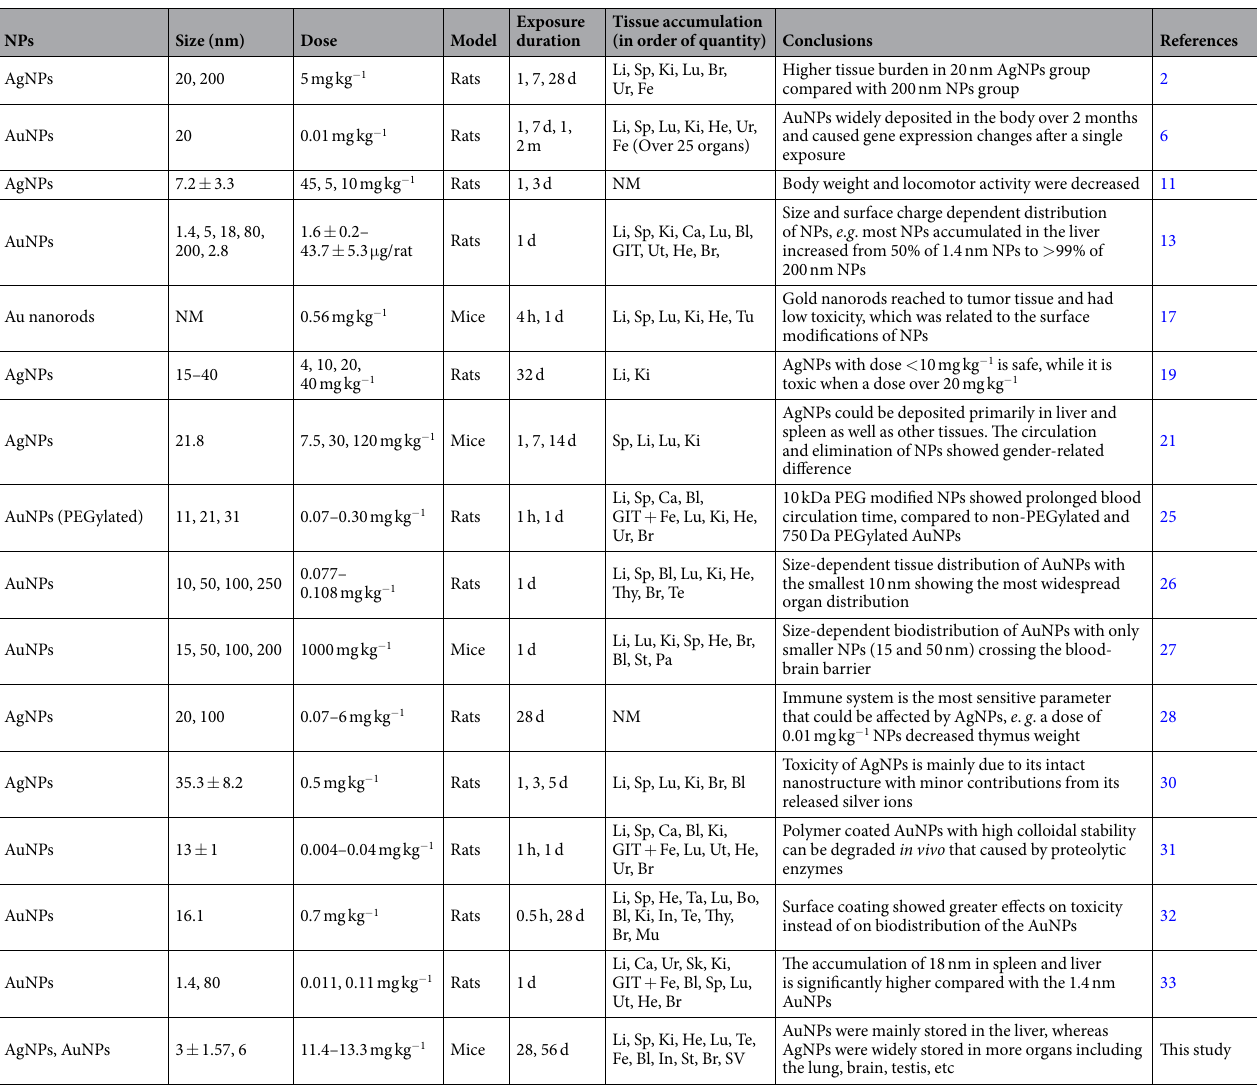
Table 1. Summary of biodistribution or toxicity of AuNPs/AgNPs in rodents via exposure of intravenous injection. The abbreviations are used in the Table: NM – not mentioned, h – hour, d – day, w – week, m – month, Br – brain, He – heart, Li – liver, Lu – lung, Ki – kidney, In – intestine, Sk – skin, Sp – spleen, GIT – gastro-intestinal tract, Fe – feces, St – stomach, Te – testes, Thy – thymus, Tu – tumor, Ut – uterus, Ur – urine, Ca – carcass, Bl – blood, Bo – bones, SV – seminal vesicle, Mu – muscle, Pa –pancreas, Ta –